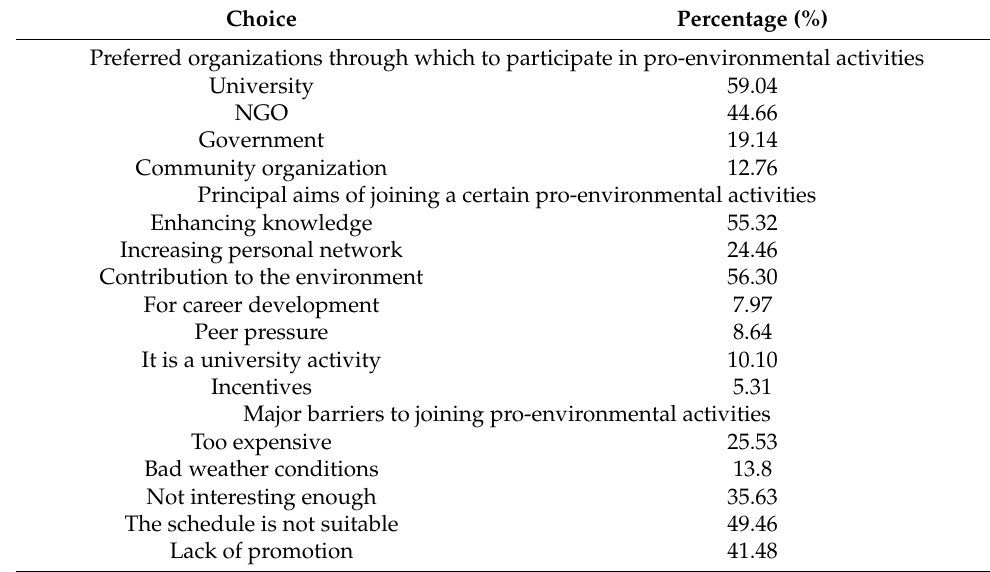
Table 9. Major organizations, aims, and barriers to joining pro-environmental